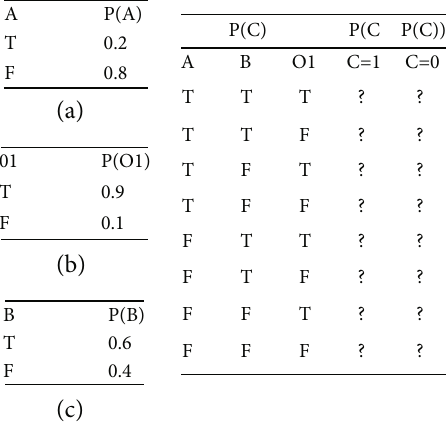
Figure 5: (a) – (c) show the prior probabilities of node A and node B , which represent locations in a region. (c) shows the posterior probabilities (missing values) that are yet to be